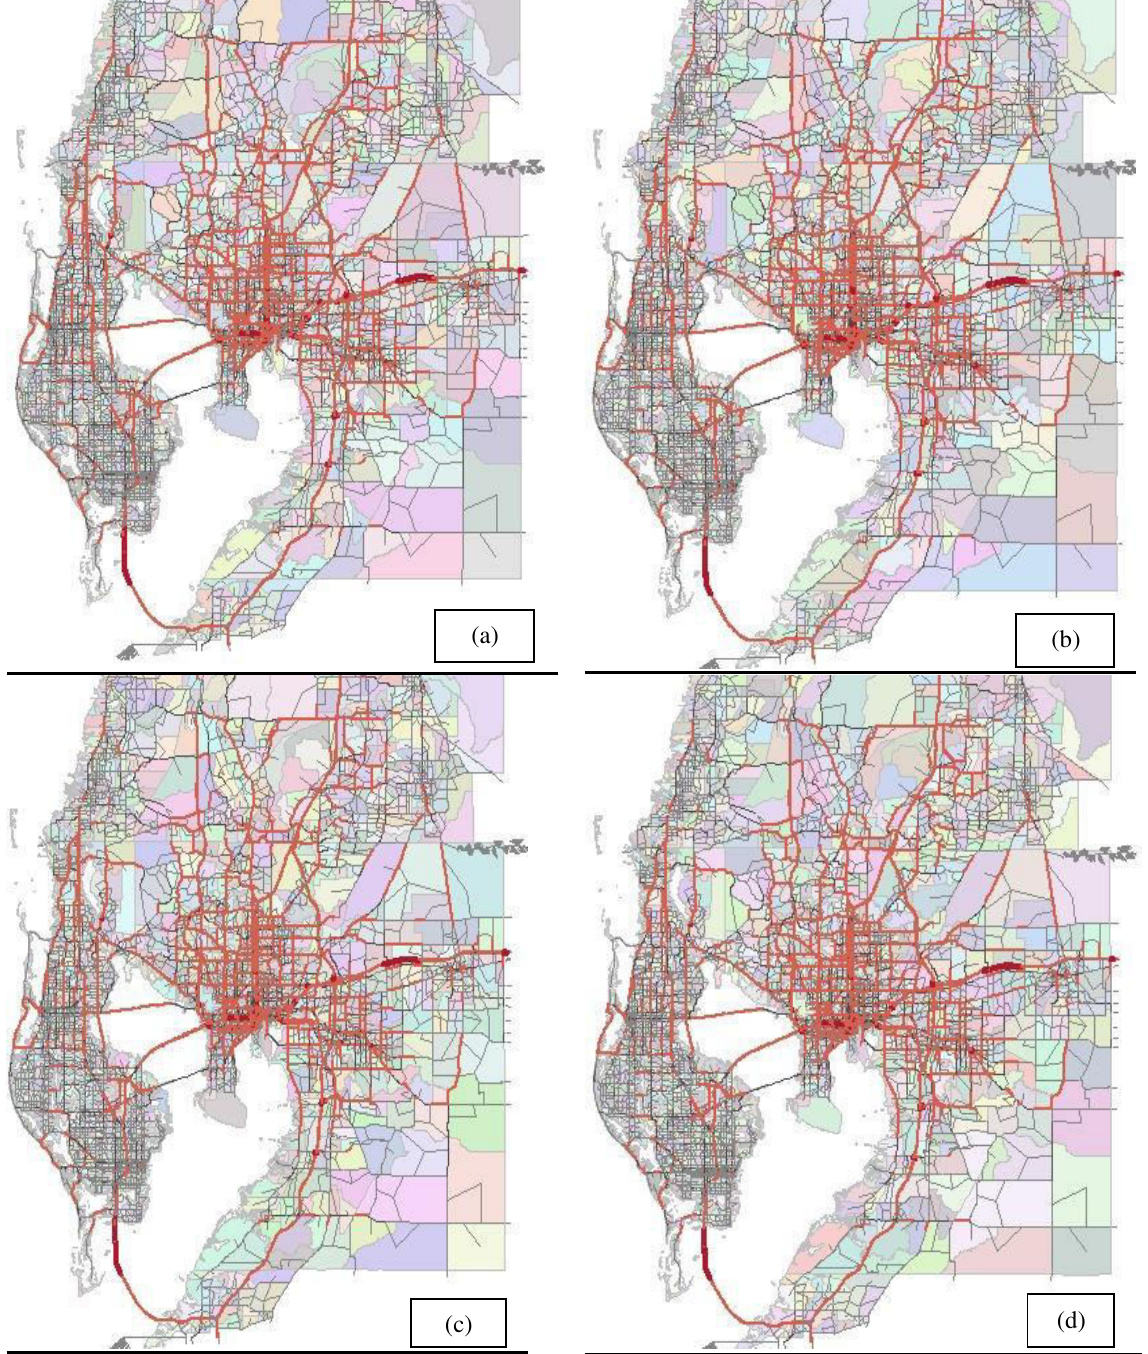
Figure 9 Model results for the total volume-to-capacity ratio for all relocation scenarios; (a) 2035 base scenario; (b) Scenario I: relocate within TAZ scenario; (c) Scenario II: leave region scenario; (d) Scenario III: proportional relocation